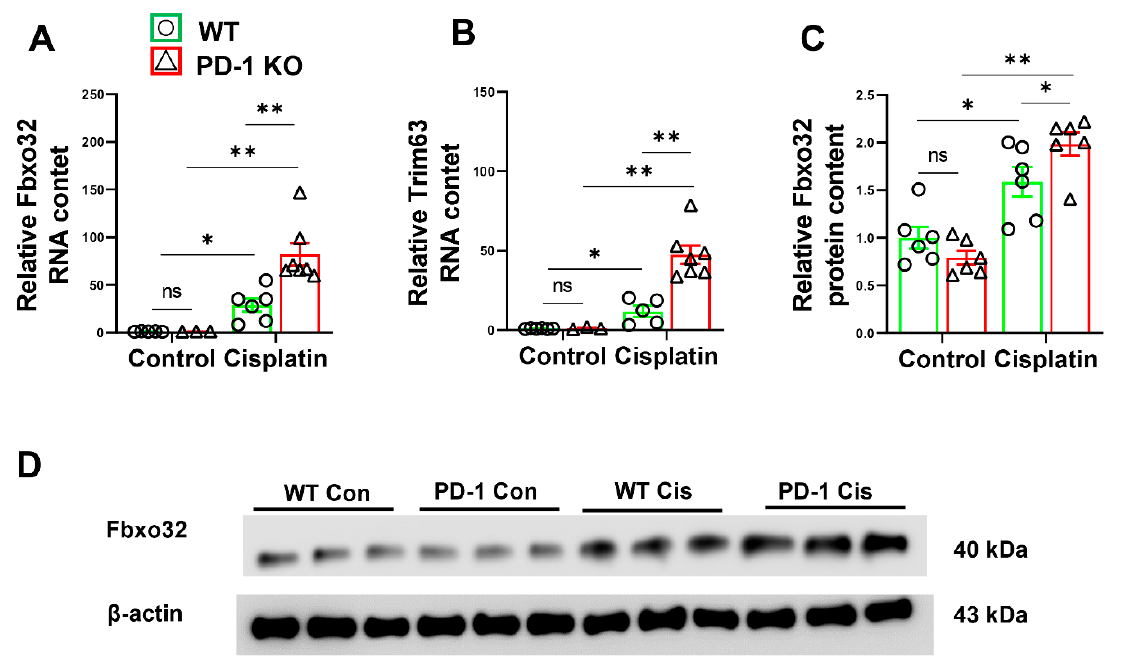
Figure 4. PD-1 − / − contributed to the expression of E3 ubiquitin-protein ligases after cisplatin treatment. ( A ) The relative mRNA levels of Fbxo32 in skeletal muscle. ( B ) The relative mRNA levels of Trim63 in skeletal muscle. ( C ) The relative protein levels of Fbxo32 in skeletal muscle. ( D ) The representative protein bands of Fbxo32 and β -actin in skeletal muscle. mRNAs were normalized to glyceraldehyde-3-phosphate dehydrogenase (GAPDH).Proteins were normalized to β -actin. n = 5–6 per group. * p < 0.05; ** p < 0.01; ns: non-significant. all values are mean ± SEM.